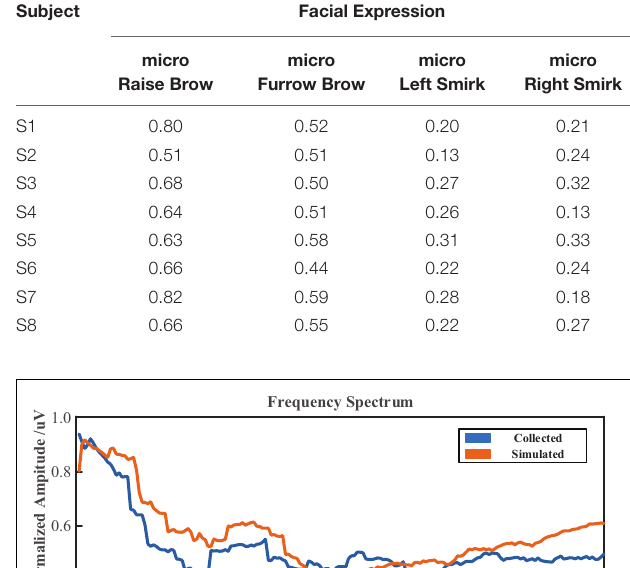
TABLE 7 | Pearson correlation coefficient of spectrum.